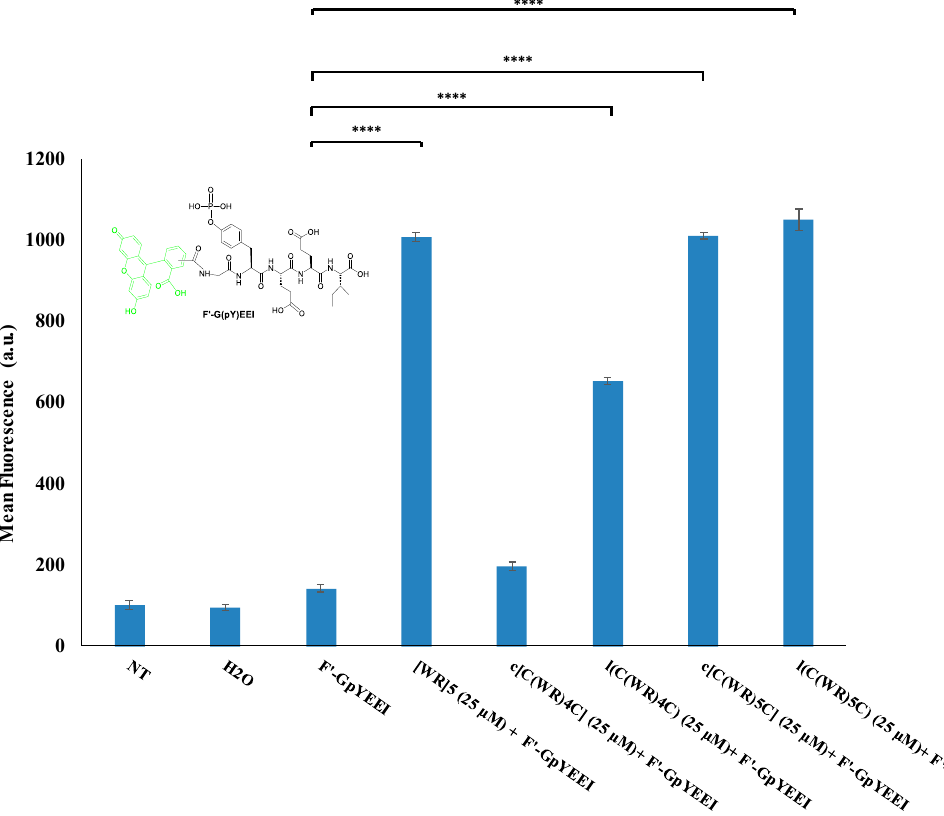
Figure 7. Fluorescence-activated cell sorter (FACS) analysis of F ′ -GpYEEI (5 µM) using l(C(WR) 5 C) and c[C(WR) 5 C] at 25 µ M in CCRF-CEM cells after 3 h incubation ( n = 3) (if p < 0.05 then *, if p < 0.01